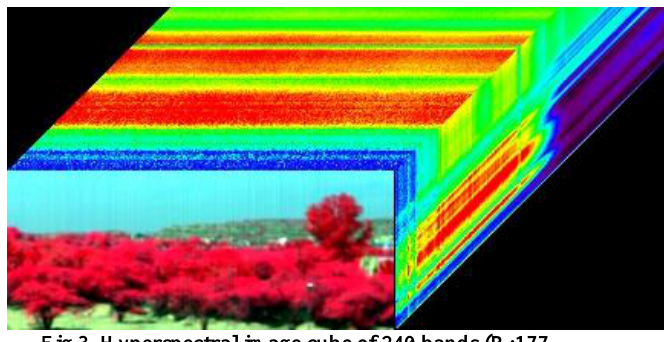
Fig.3. Hyperspectral image cube of 240 bands (R:177, G:119, B:59).